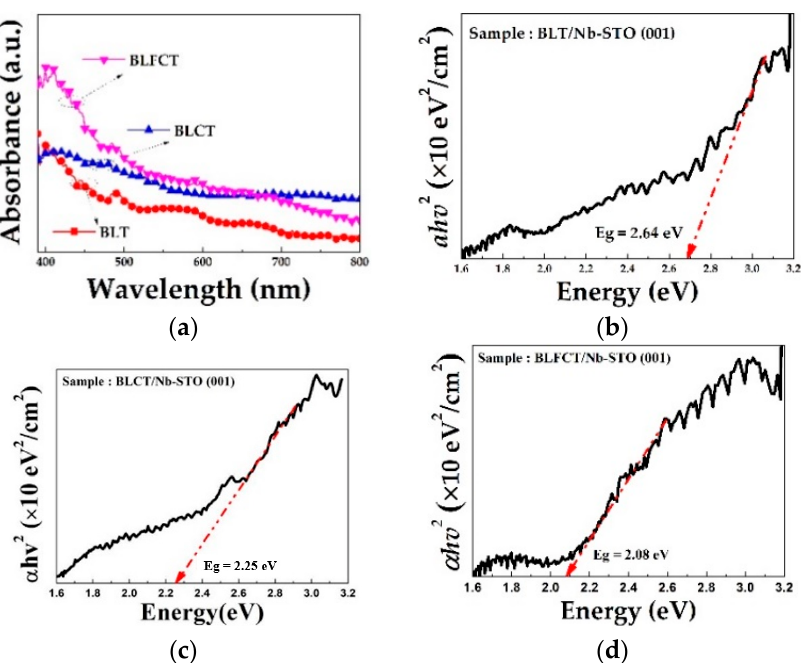
Figure 5. Optical response of BLT, BLCT, and BLFCT films grown on the Nb-SrTiO 3 (001) substrate; ( a ) Absorbance data with the wavelength (385–800nm), and ( b – d ) bandgap energy estimated by extrapolating the linear part of the ( α h ν ) 2 versus energy plots for BLT, BLCT, and BLFCT on the Nb-STO substrate.